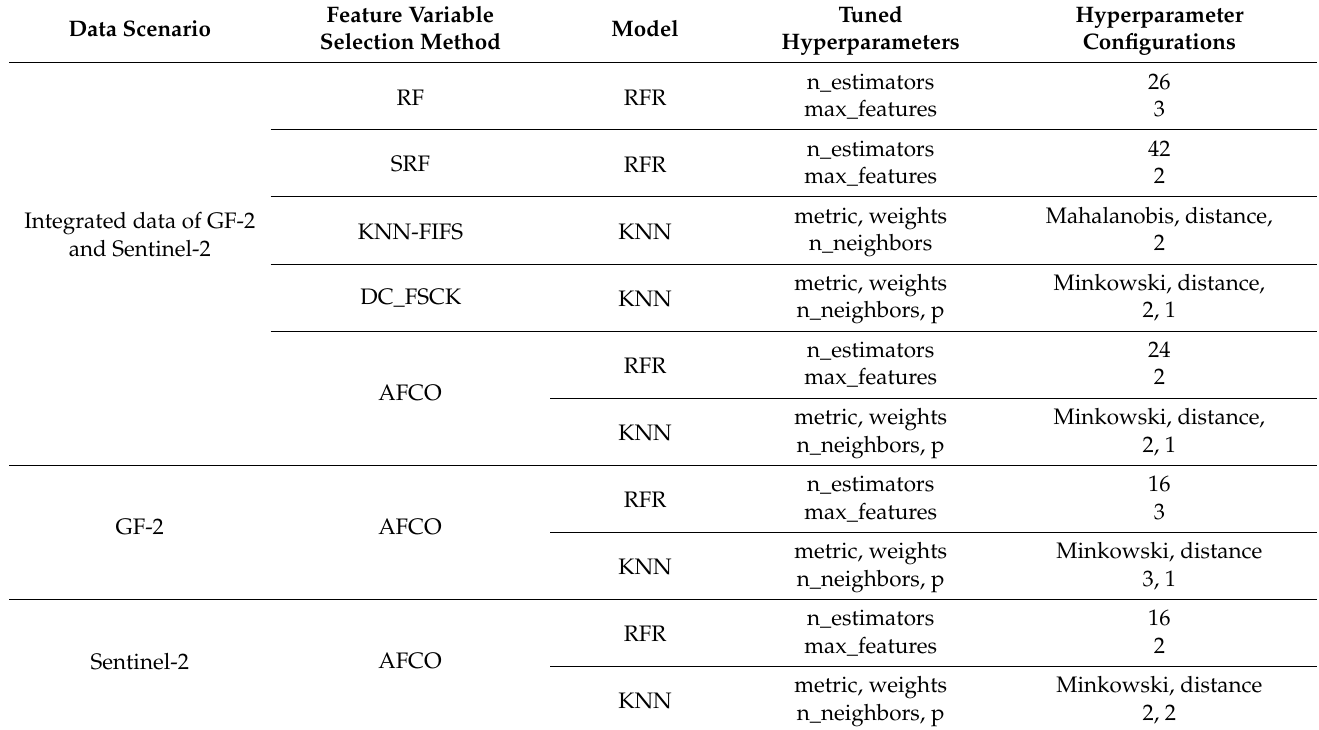
Table 7. Tuned hyperparameters and best configurations for each data scenario and estimation